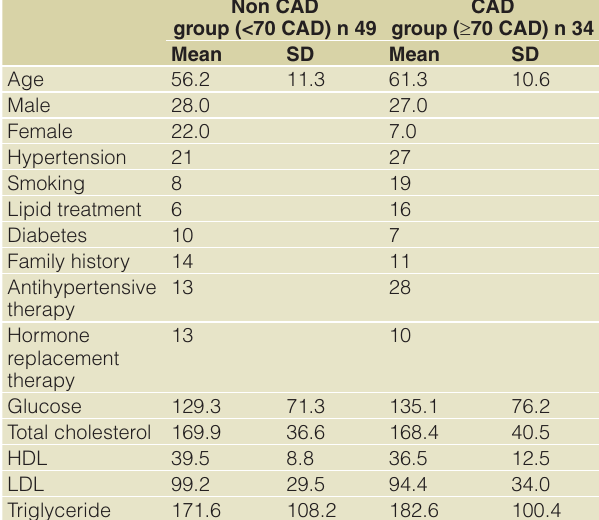
Table 2. Characteristics of catheterization sample participants. Continuous measures, mean ± S.D., or number and percent with stated